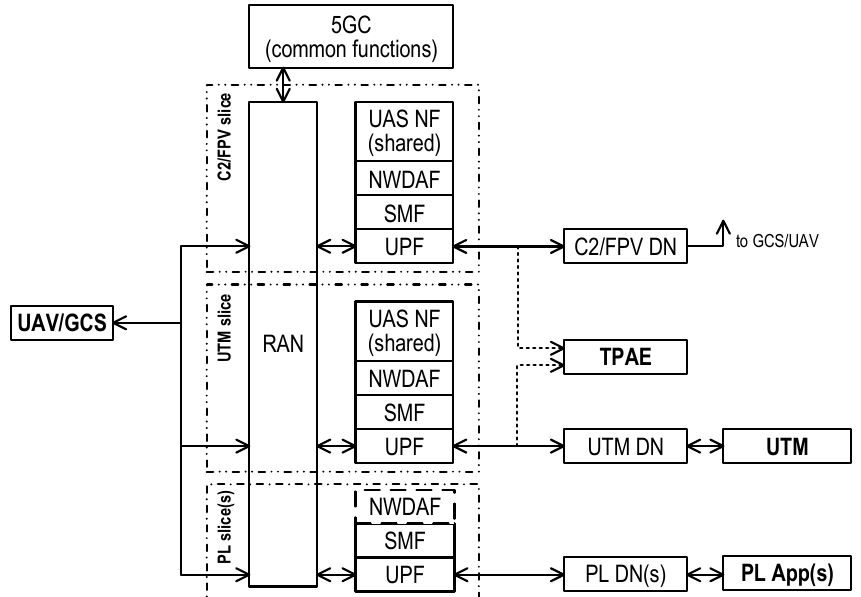
Figure 6. 5GS UAS support by network slices and NWDAF